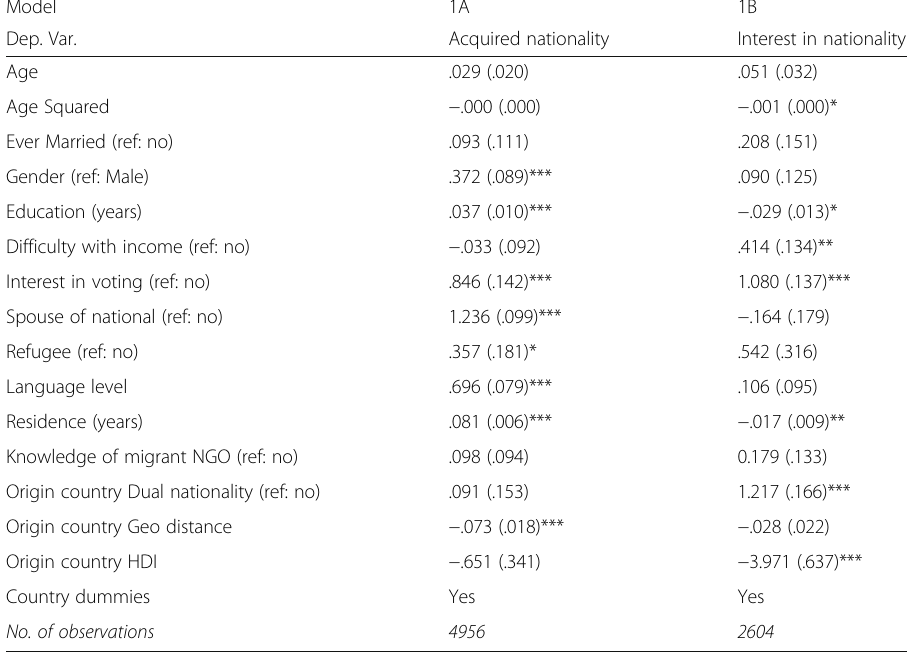
Table 3 Logistic regression of acquisition and interest, standardised coefficients Model 1A Dep.